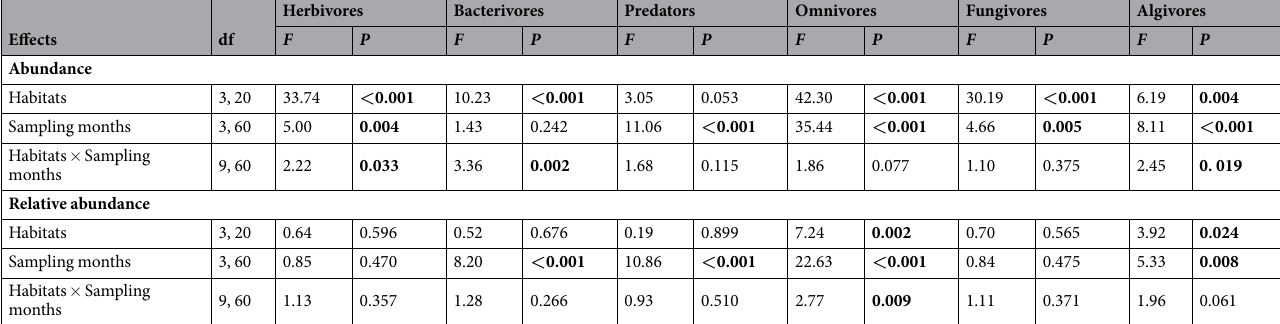
herbivores, bacterivores and fungivores. This may result from the different influences of the plant community and soil property variables, which differed among the sampling months. A previous study showed that soil nematodes are affected by seasonal fluctuations in soil conditions 34 .